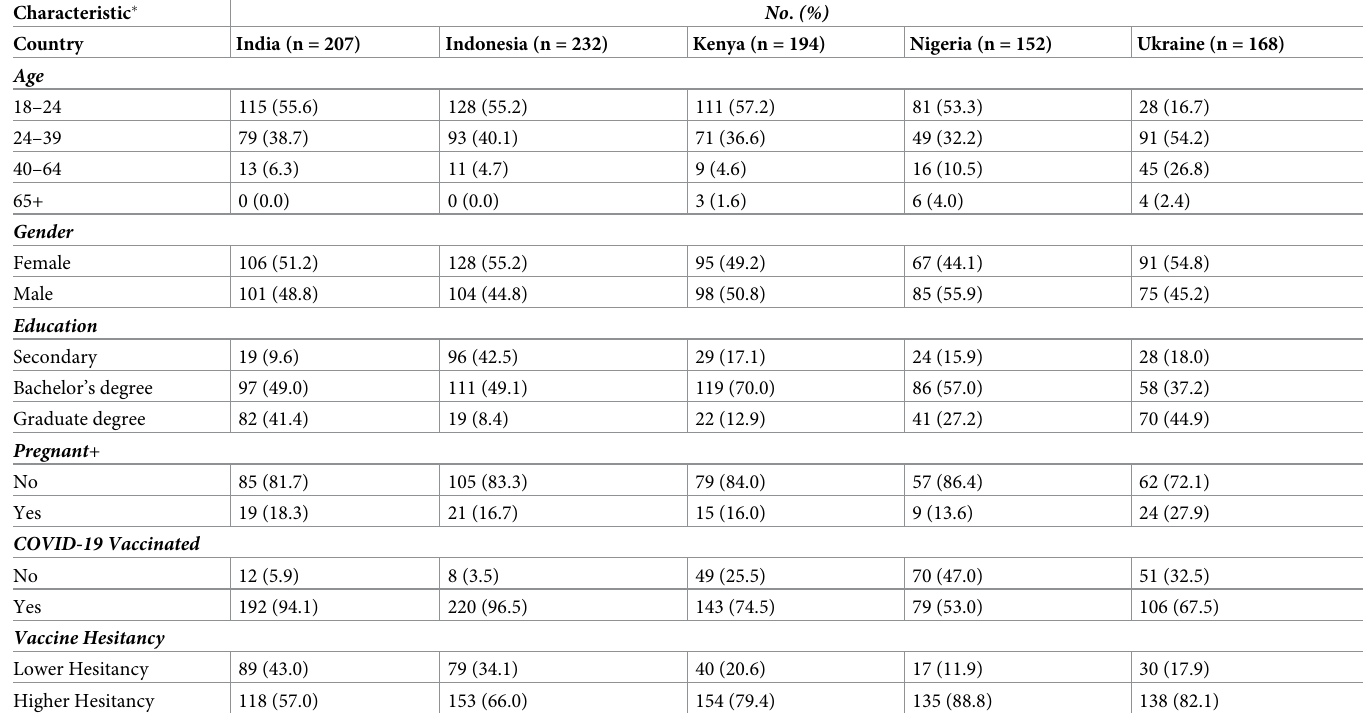
Table 1. Participant characteristics (n =